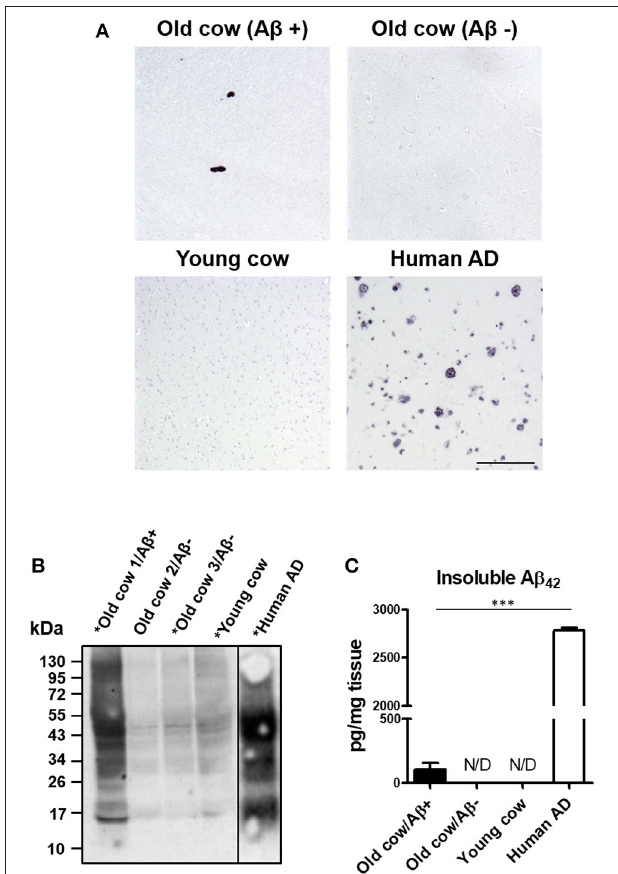
FIGURE 2 | Histological and biochemical characterization of materials used for in vivo transmission experiments. (A) Representative pictures of cattle brains stained with the 4G8 anti-A β antibody that were utilized for in vivo inoculation, including young animals and old cows with (A β + ) and without A β (A β − ). The figure also shows the staining for the AD human brain utilized for these experiments as a positive control. (B) Aliquots of 10 µ L from the total brain extracts from old and young cows were analyzed by western blot using a rabbit-A β 42 polyclonal antibody. For comparison, the same amount of the AD brain extract was also included. Samples labeled with an asterisk (*) were used for the in vivo transmission studies described in Figure 3 . A black line separating the lanes indicates gel splicing. (C) Quantification of insoluble A β 42 aggregates by serial extraction, centrifugation and ELISA (see Methodology) expressed in pg per mg of brain tissue. Data represent the average ± standard error of the mean for three replicates. Differences on the levels between human AD and old cow (A β + ) brains were evaluated by unpaired student T-test (*** p < 0.001). Insoluble A β was not detected (N/D) in either the old cow (A β − ) or the young cow brain